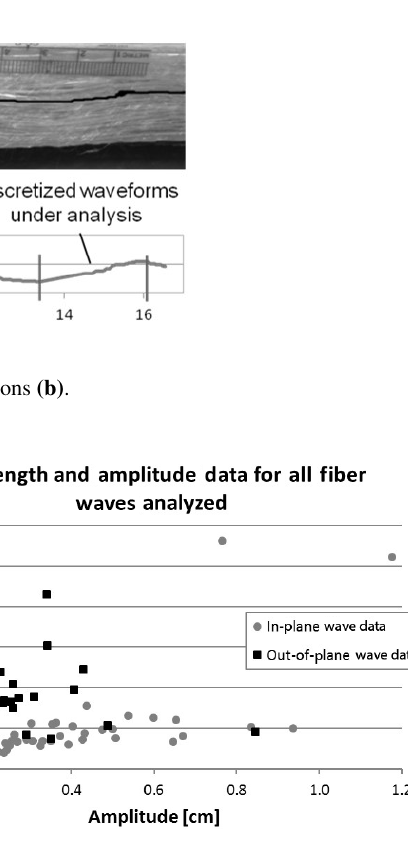
Figure 4. Collected OP and IP wave data (left to right, respec-